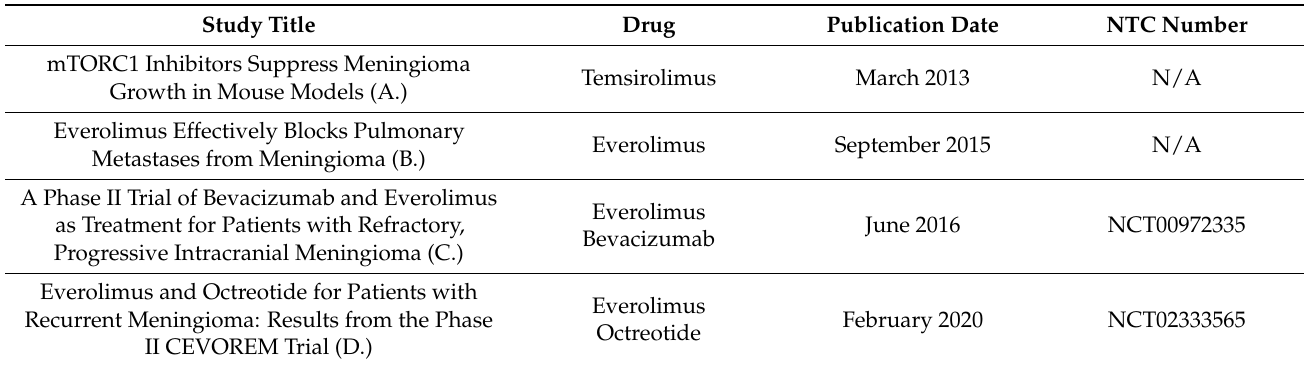
Table 2. Publications on mTOR inhibitors in meningioma (complete). Comprehensive summary of all complete in vitro studies involving mTOR inhibitors in meningiomas